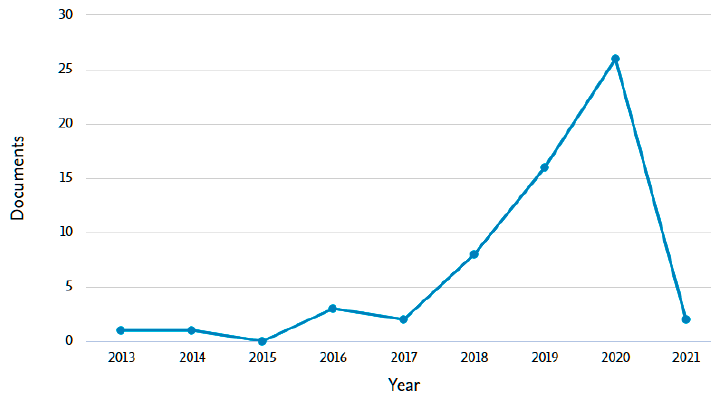
Figure 4. Results by year. Scopus.